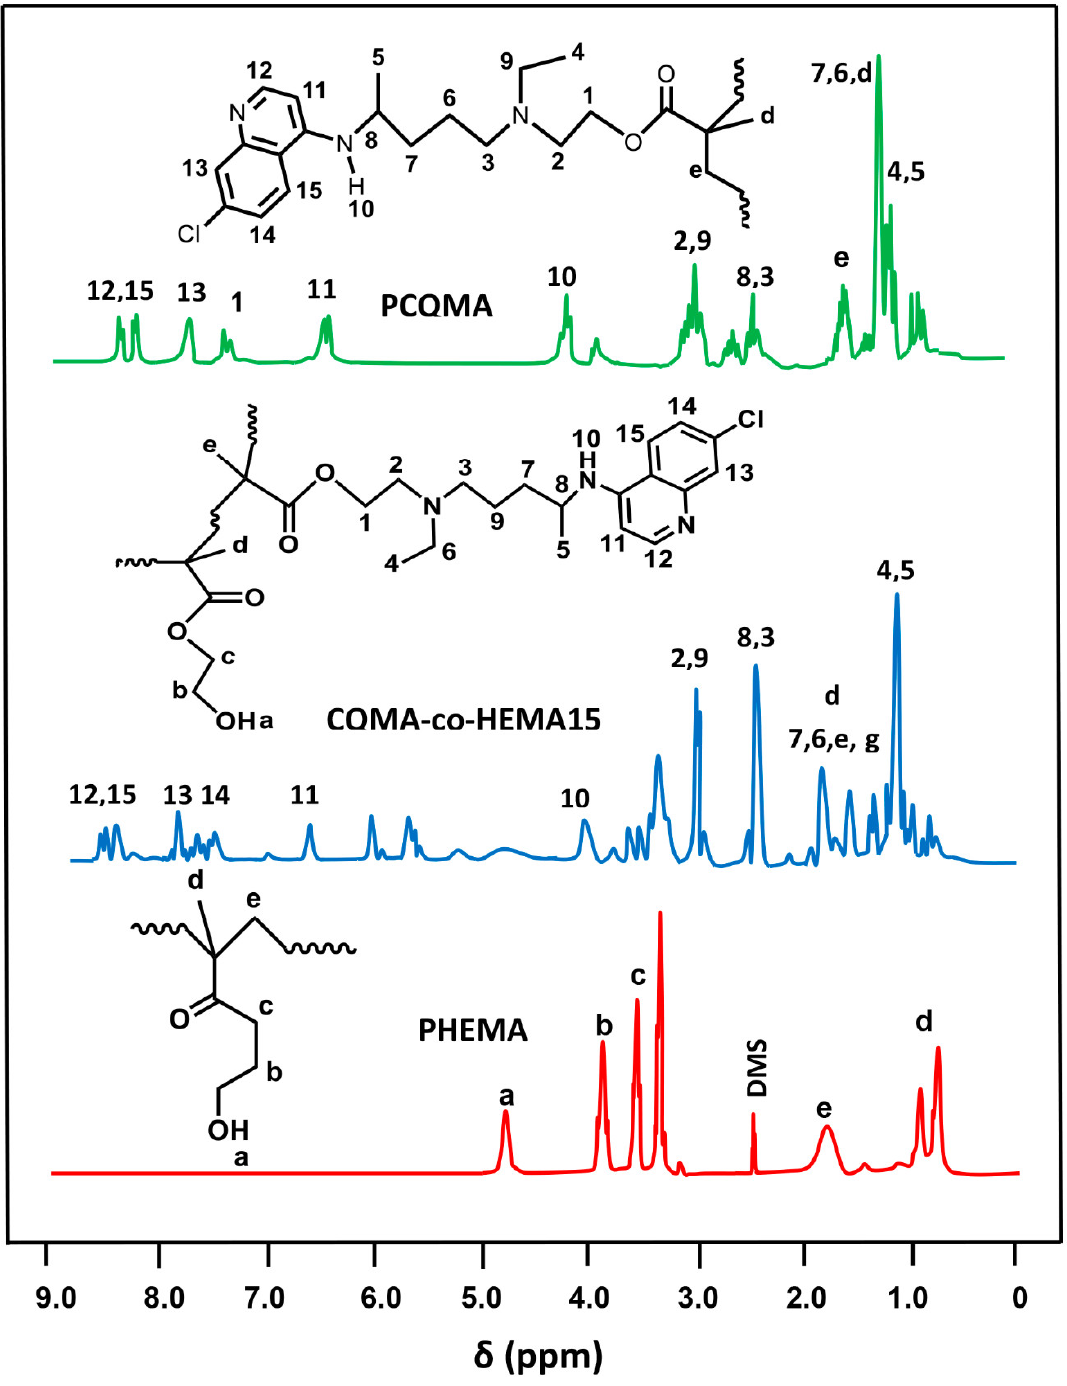
Figure 4. 1 H NMR spectra of PCQMA, PHEMA homopolymers and CQMA-co-HEMA15 copolymers.